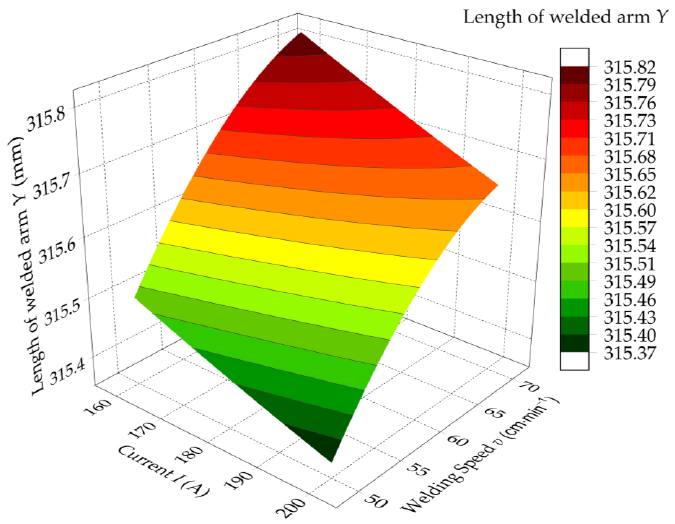
Figure 6. Dimension of the part as a function of welding speed and current (stampings dimension Z = 316.00 mm). According to this graph, maximum deformations (smaller resulting dimensions of the welded stamping Y ) are achieved at higher currents and lower welding speeds, i.e., while producing more heat. In addition, it is clearly evident from the graph that it is not a general plane, but rather a curved surface as a result of the welding speed (Equation (6)). 3.2. ANN Results The main structure of ANNs is shown in Figure 7. The structure with a single hidden layer was used. Figure 7. The main structure of ANN.